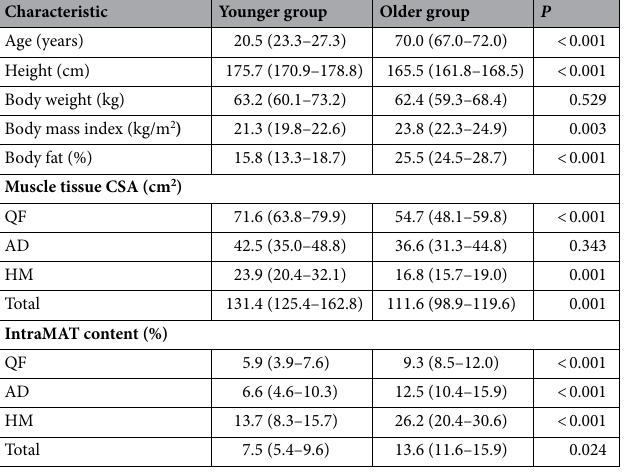
Table 1. Characteristics of the participants. Median (25th to 75th percentile), vs. younger group, CSA cross-sectional area, IntraMAT intramuscular adipose tissue, QF quadriceps femoris, AD hip adductors, HM